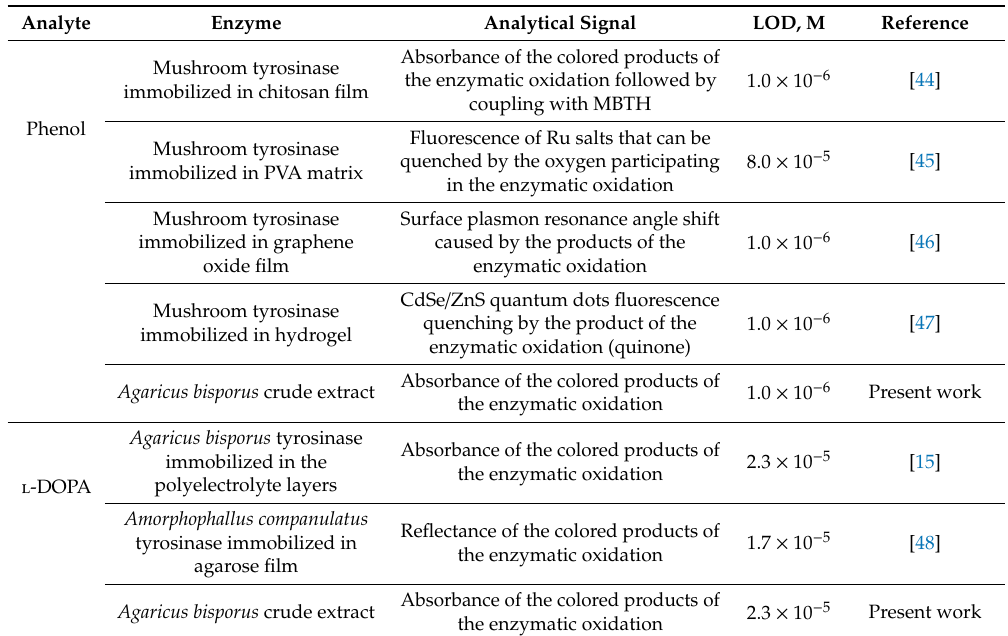
Table 7. Comparison of spectroscopic tyrosinase-based procedures for phenol and l -DOPA determination.